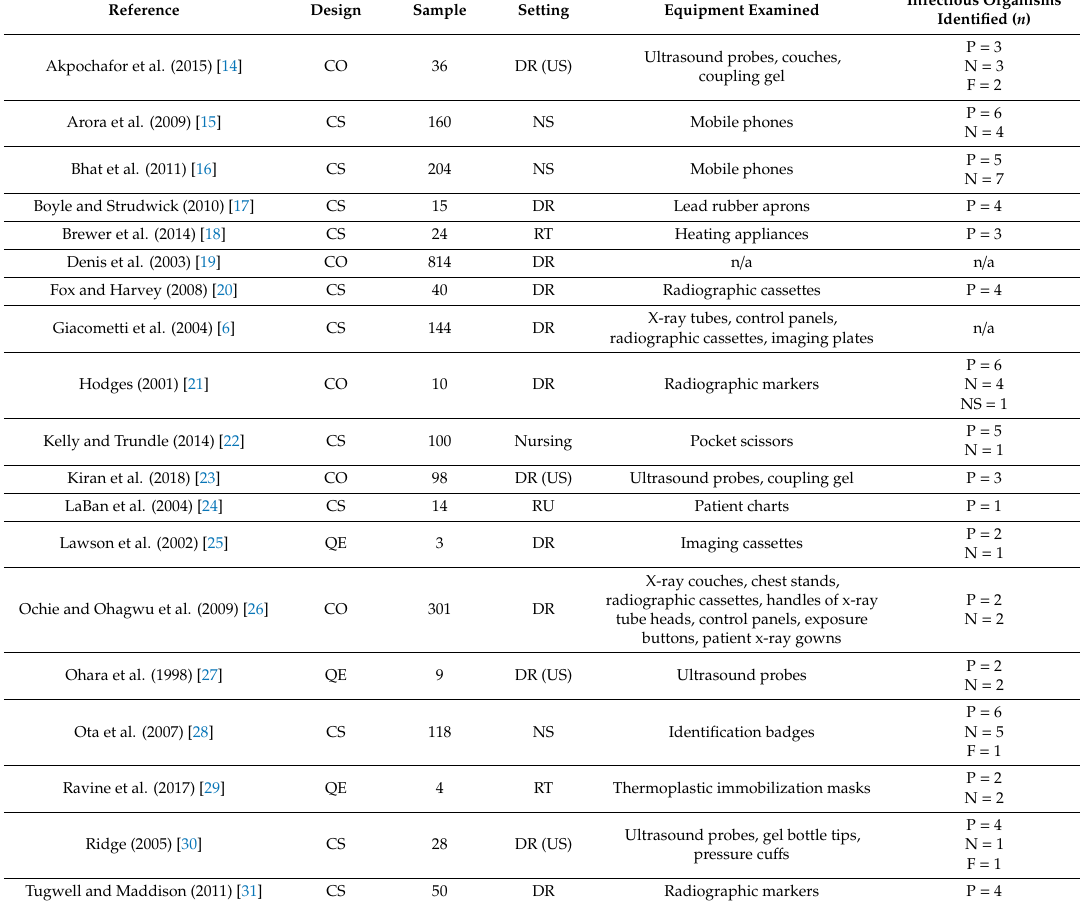
Table 2. Characteristics of included